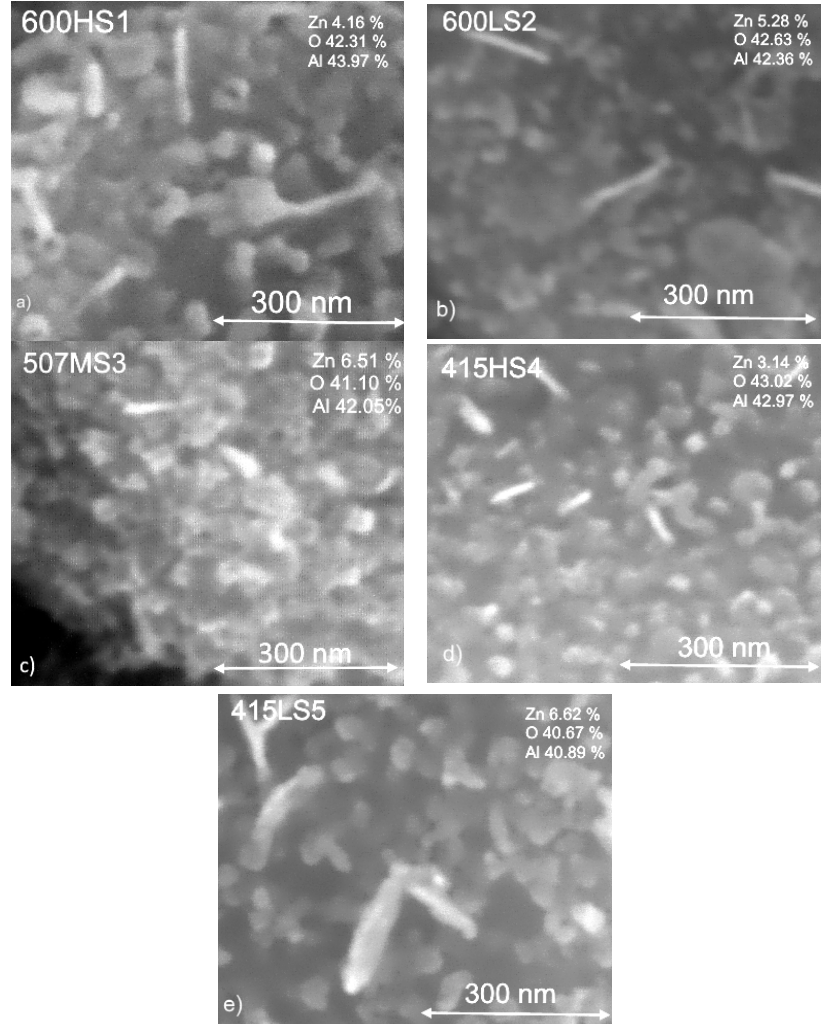
Figure 3. Higher magnification SEM micrographs of the different thin ZnO films supported on Al 2 O 3 substrates. EDX results are indicated as insets to each micrograph. Panels ( a – e ) correspond to films obtained employing the five different thermal treatments implemented. Refer to Table 1 for full details.